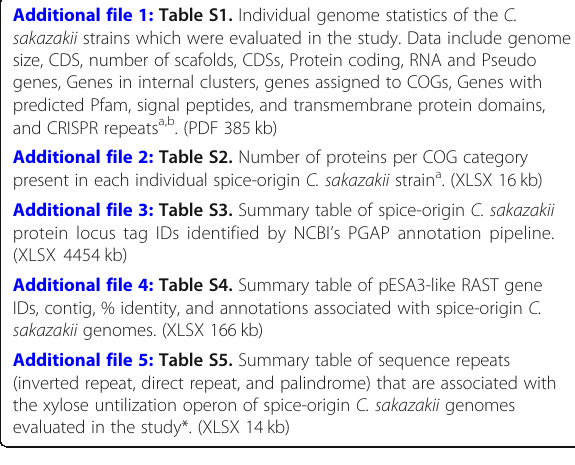
Abbreviations MIGS: Minimum information about a genome sequence; NAS: Non-traceable author statement; TAS: Traceable author